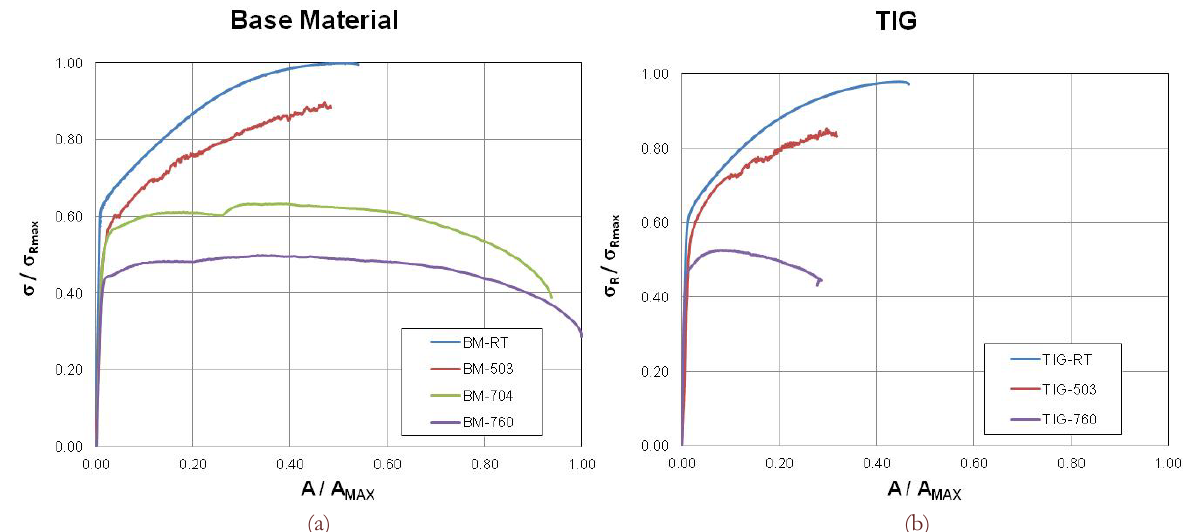
Figure 2: Static behaviour of base (a) and TIG welded (b) material.